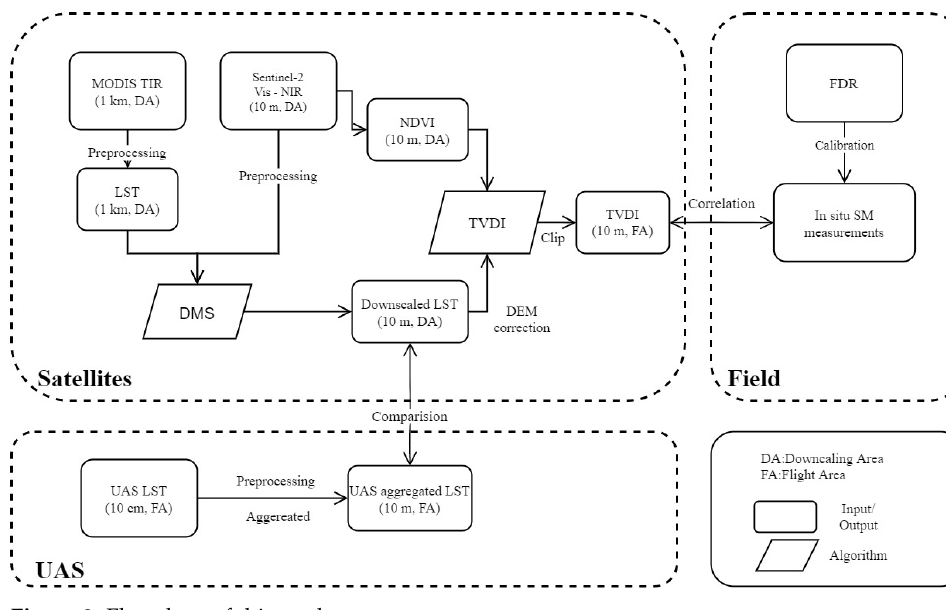
Figure 2. Flowchart of this